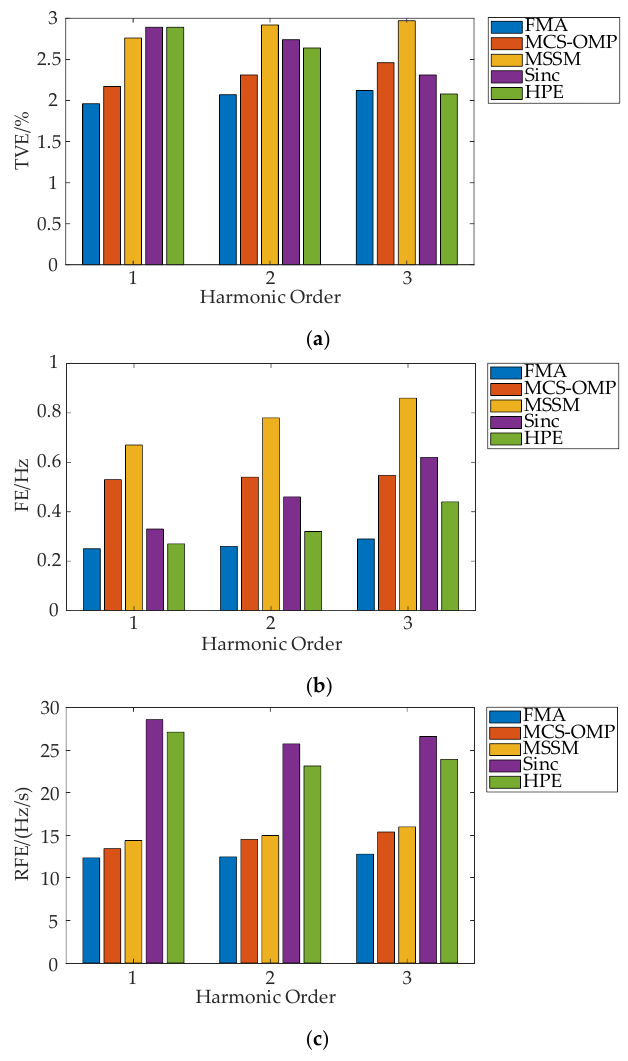
Figure 5. Low-frequency harmonic modulation test results: ( a ) TVE values for each algorithm; ( b ) FE values for each algorithm; ( c ) RFE values for each algorithm.